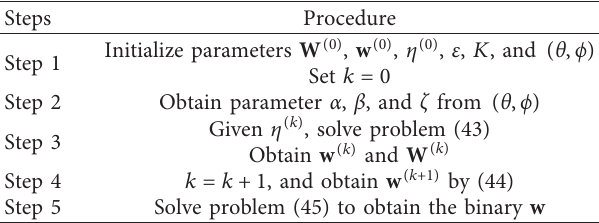
Table 2: Thinning virtual array with priori